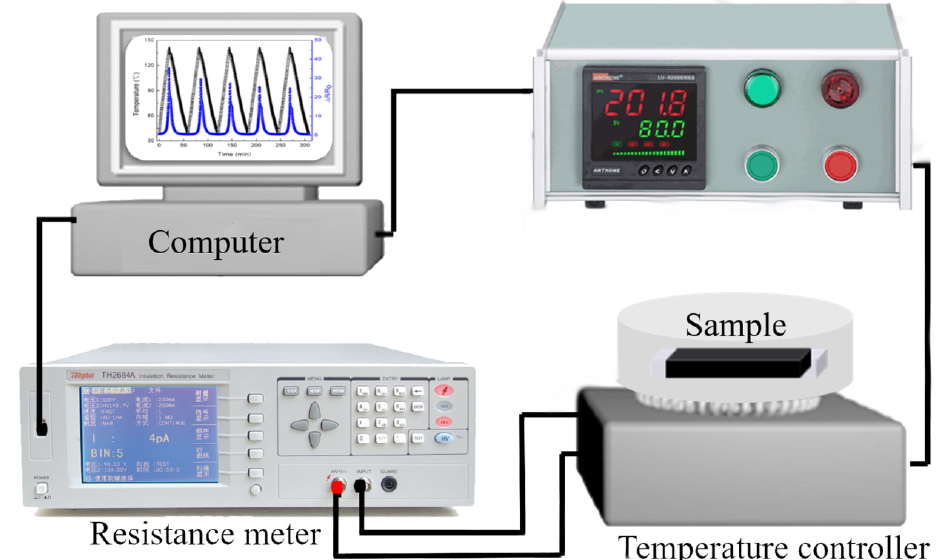
Figure 1. The self-designed equipment schematic diagram.